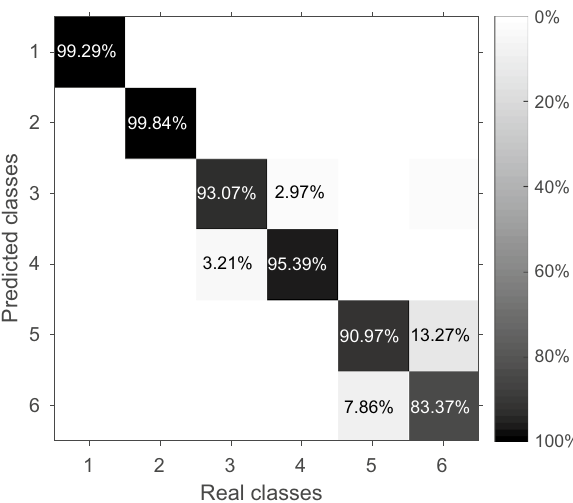
Figure 4. Confusion matrix regarding 10 trials including the dataset of all volunteers in the kNN classification.